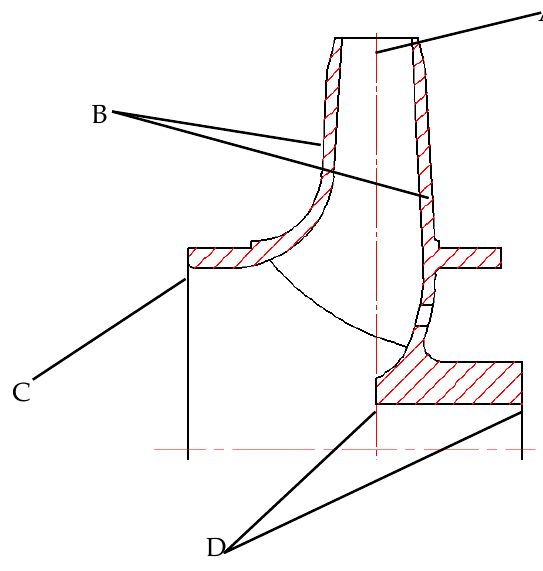
Figure 19. The machining process of the impeller.